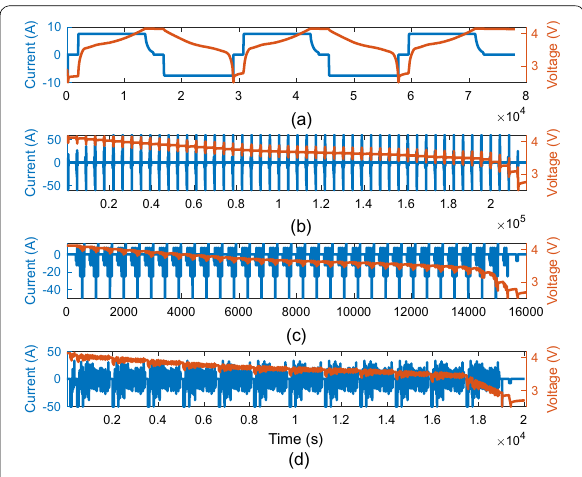
Figure 2 Current and voltage profiles of a capacity test, b hybrid pulse power characterisation test, c dynamic stress test, and d urban dynamometer driving